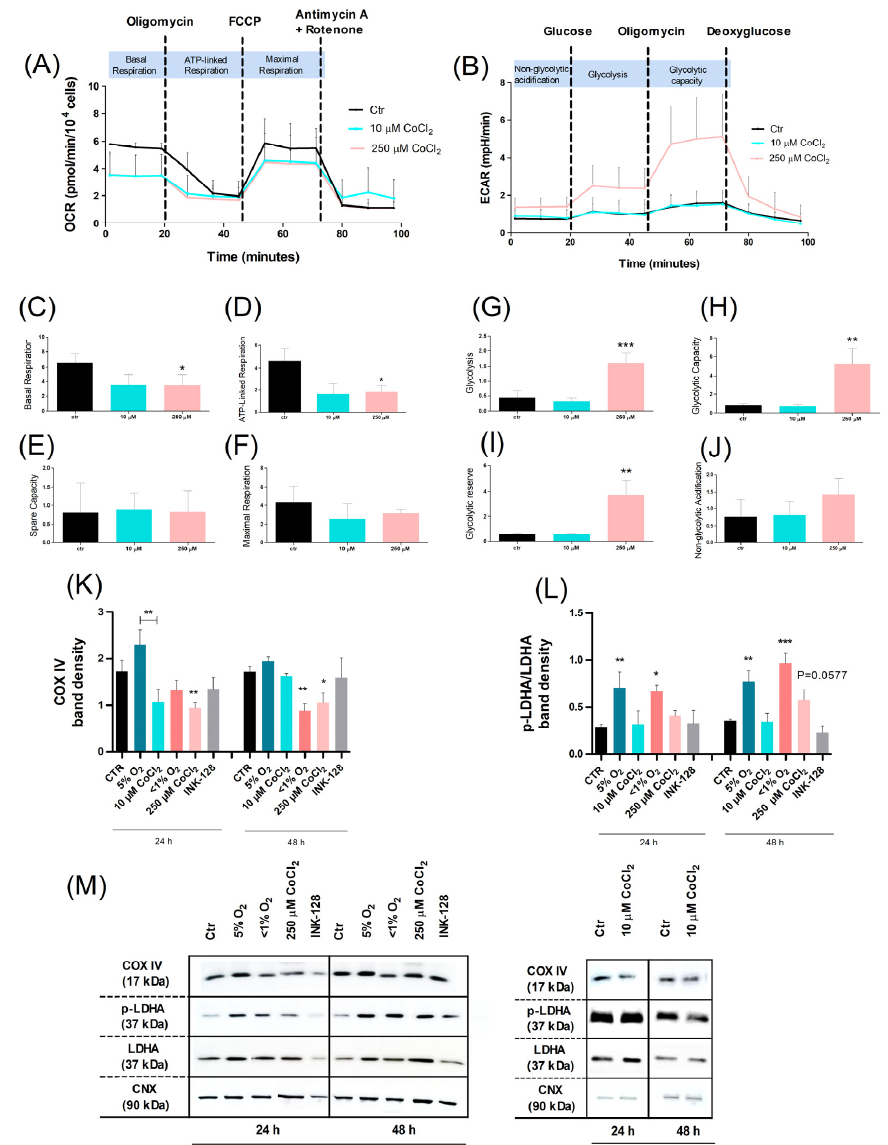
Figure 2. Comparative analysis of the effects of hypoxia and CoCl 2 on UC-MSC metabolism. UC- MSCs were cultured for 24 and 48 h under different O 2 levels (21%, 5%, <1%) or CoCl 2 concentrations (10 µ M and 250 µ M); cells were treated with the mTOR dual inhibitor INK-128 as a positive control for a quiescent state. To assess both the oxidative metabolism and the extracellular acidification rate of UC- MSC, OCR and ECAR were measured, respectively, with a Seahorse XF24 Analyzer. Three measures were performed after each drug injection. ( A , B ) Schematic image of the metabolic modulator injection sequence and the parameters that could be obtained with the OCR and ECAR assays. ( A ) OCR profile throughout the experiment, ( C ) basal respiration, ( D ) ATP-linked respiration, ( E ) spare capacity, and ( F ) oxygen maximal consumption. ( B ) ECAR profile throughout the experiment, ( G ) glycolysis, ( H ) glycolytic capacity, ( I ) glycolytic reserve, and ( J ) non-glycolytic acidification. Spare capacity (OCR) and glycolytic reserve (ECAR), not represented in the image, were calculated using the formulas (maximal respiration—ATP-linked respiration) and (glycolytic capacity—glycolysis), respectively. Protein level analysis of ( K ) COX IV and ( L ) p-LDHA/LDHA and the ( M ) respective representative images, performed through Western blot. The values were normalized by the expression of the loading control calnexin (CNX). The values are represented as means with SEM of at least three independent experiments. Statistical significance considered when * p < 0.05%, ** p < 0.01, and *** p <